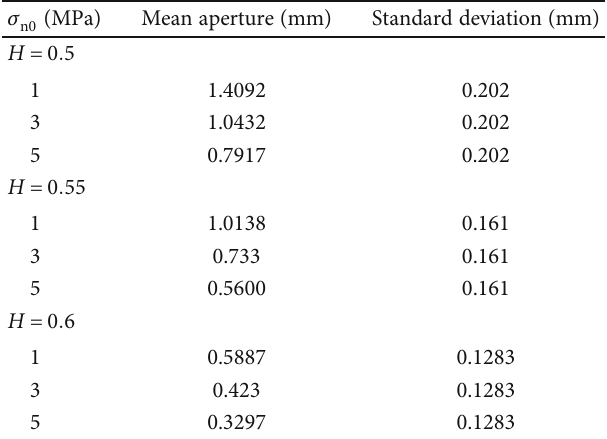
) varies with normal stress ( σ n Table 2: Statistical parameters of local mechanical aperture.